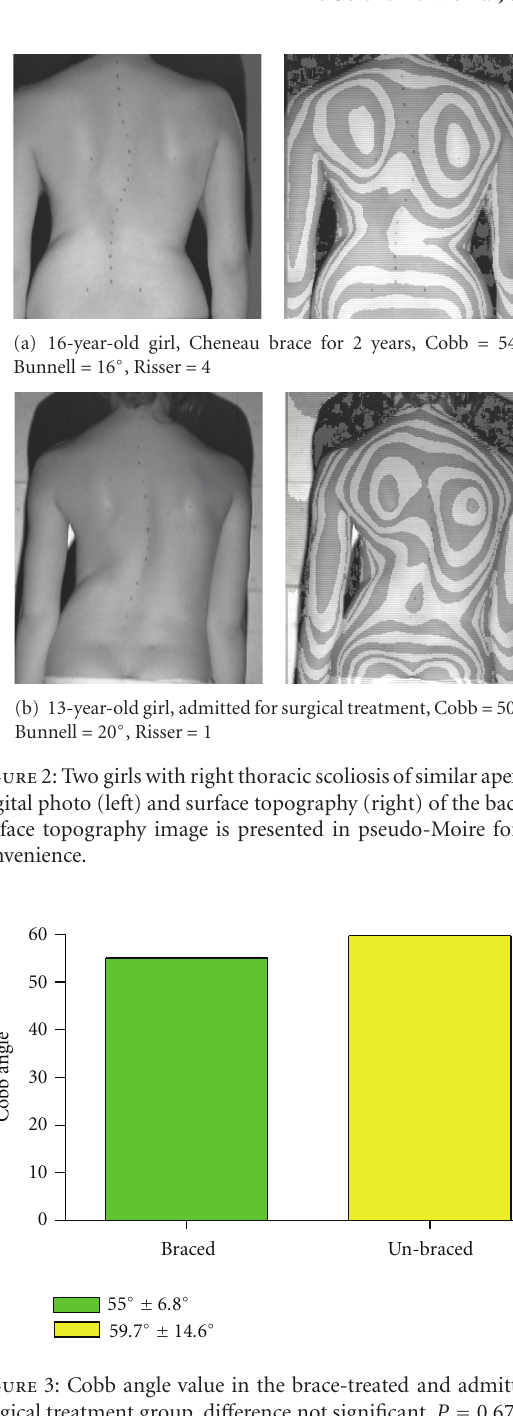
Figure 3: Cobb angle value in the brace-treated and admitted for surgical treatment group, di ff erence not significant, P = 0 .